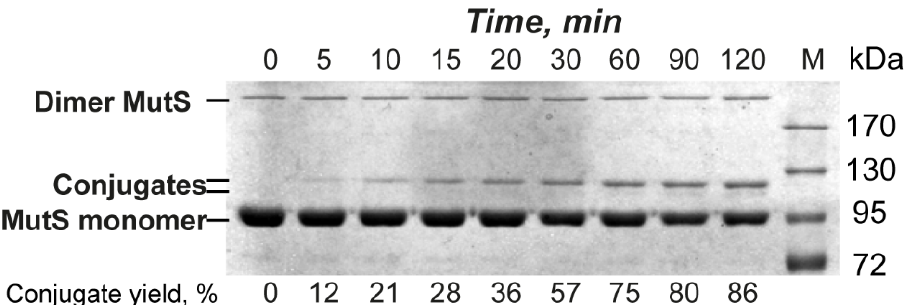
Figure 7. Analysis of MutS(N497C) (5 µM on the monomer basis) cross-linking with the 17GT-dU- macryl -8 DNA duplex (0.5 µM) by SDS-PAGE in an 8% gel. Reaction conditions: 0–120 min, 37 °C. Conjugate yields (%) are indicated under the gel lanes. The gel was stained with a Coomassie G250 solution. M: markers of protein molecular mass, kDa.